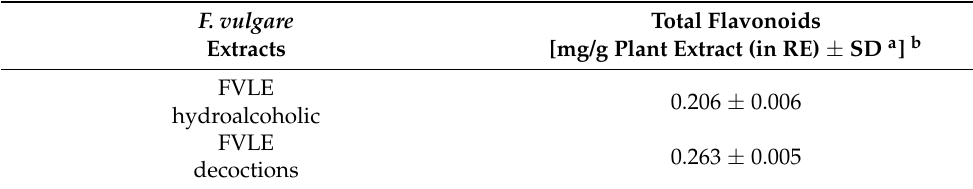
Table 4. Total amount of plant flavonoids in F. vulgare